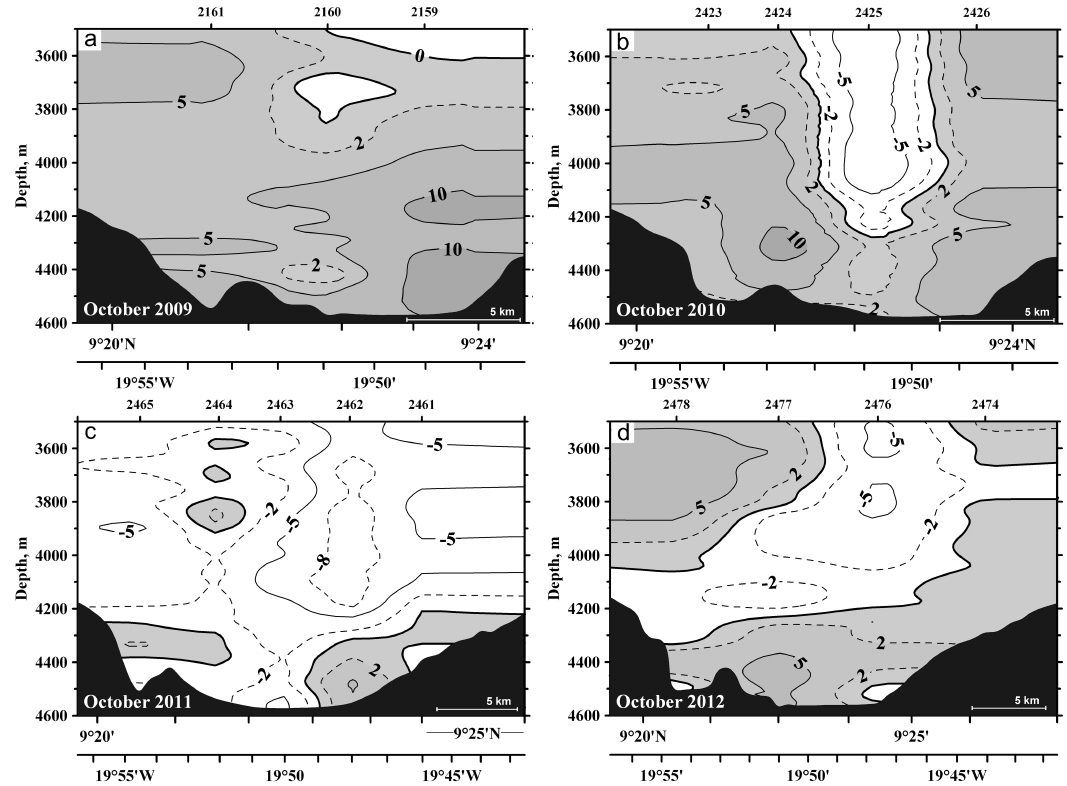
Fig. 8. Sections of velocity (normal to the section, positive to the northwest) (cms − 1 ) across the Kane Gap in October 2009 (a) , October 2010 (b) , October 2011 (c) , and October 2012 (d) . Numbers of stations are shown above and coordinates are below. The horizontal scale is shown in the bottom right corner. Figure 8a is adopted with modifications from Morozov et al.